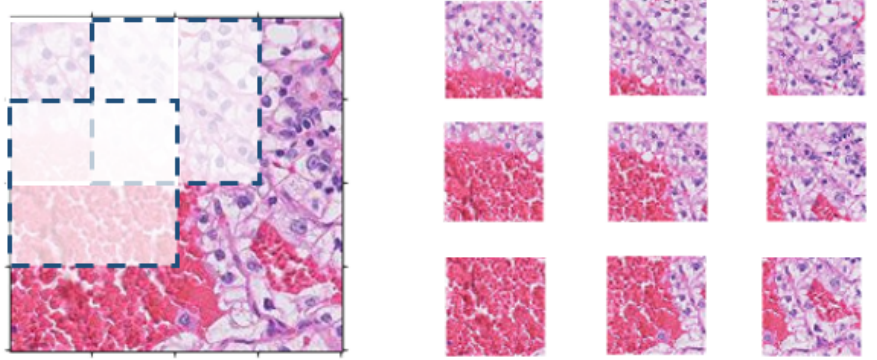
Figure 7. Tiling, extracting overlapping patches of training subjects’ WSIs.